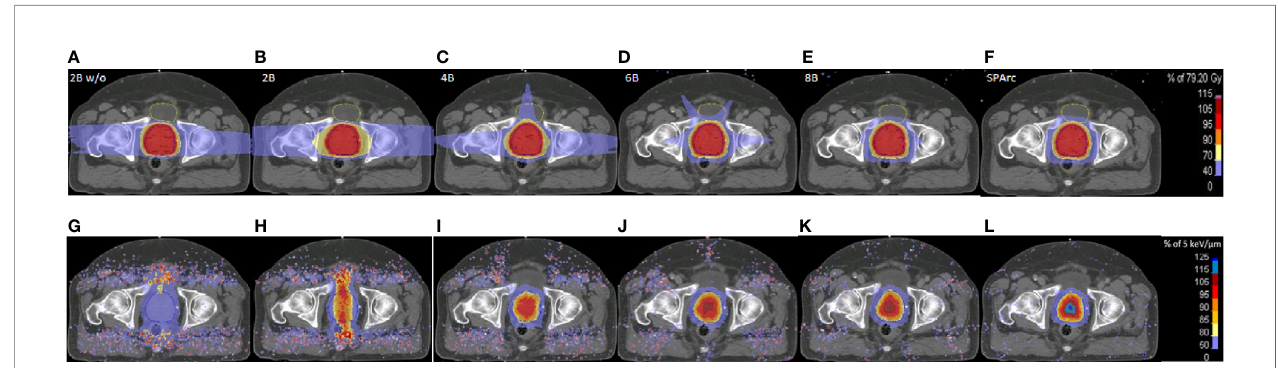
FIGURE 2 | The dose (upper row) and the LET d (lower row) distributions for 2 beams without LET d based optimization (2Bw/o, A, G ), and with LET d based optimization for 2 (2B, B, H ), 4 (4B, C, I ), 6 (6B, D, J ), 8 (8B, E, K ) beams and SPArc (F, L) for a prostate case.